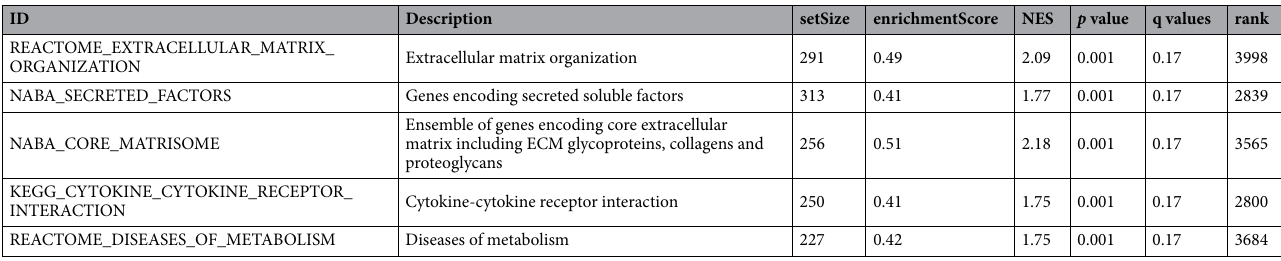
Table 2. GSEA enrichment analysis.